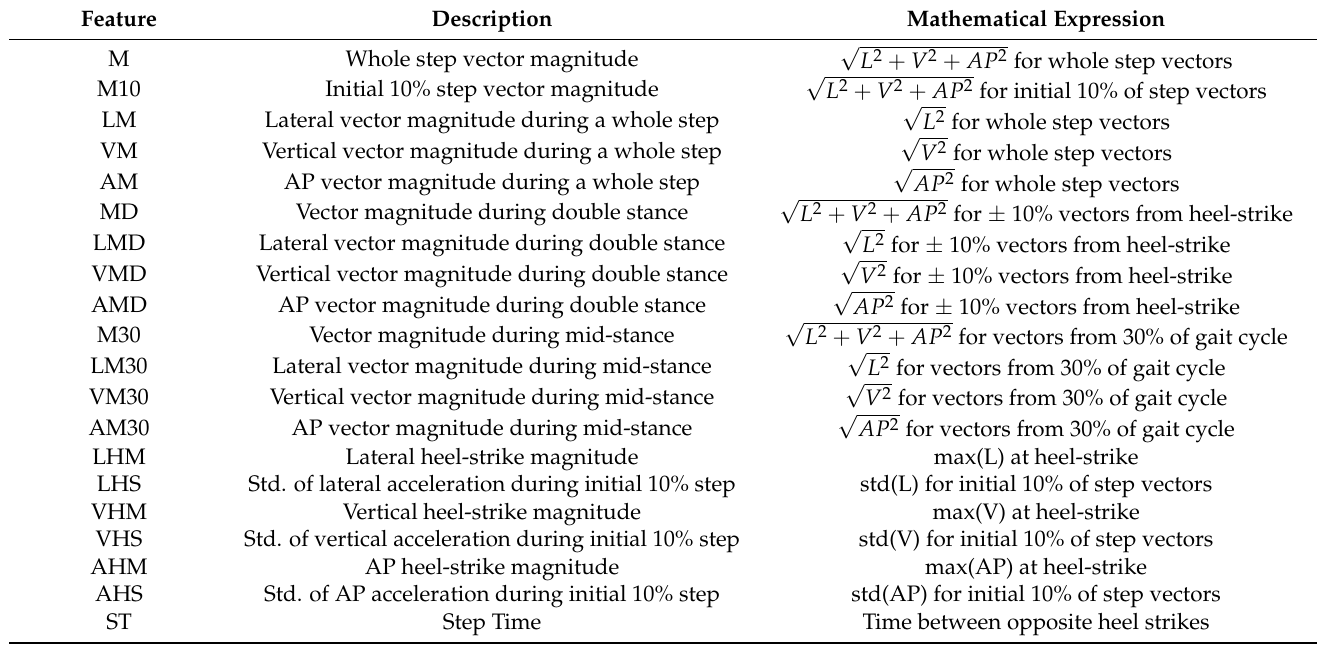
Table 2. Description of extracted